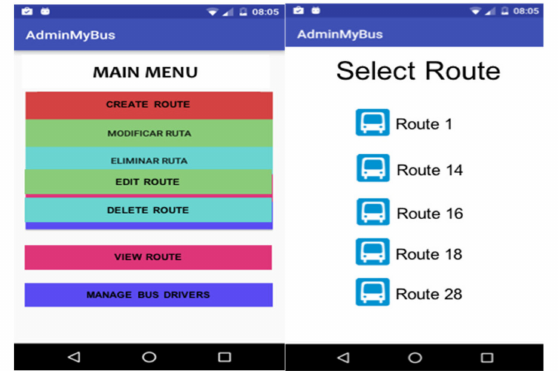
Figure 12. Interface for the creation of a new route.